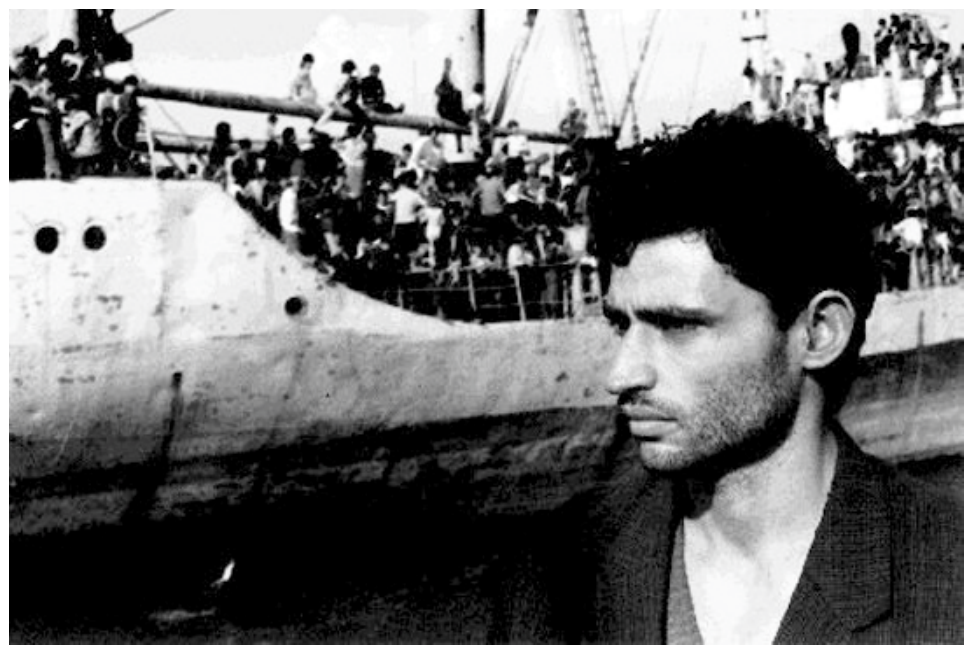
Figure 6. Shot from Gianni Amelio’s Lamerica , 1994.